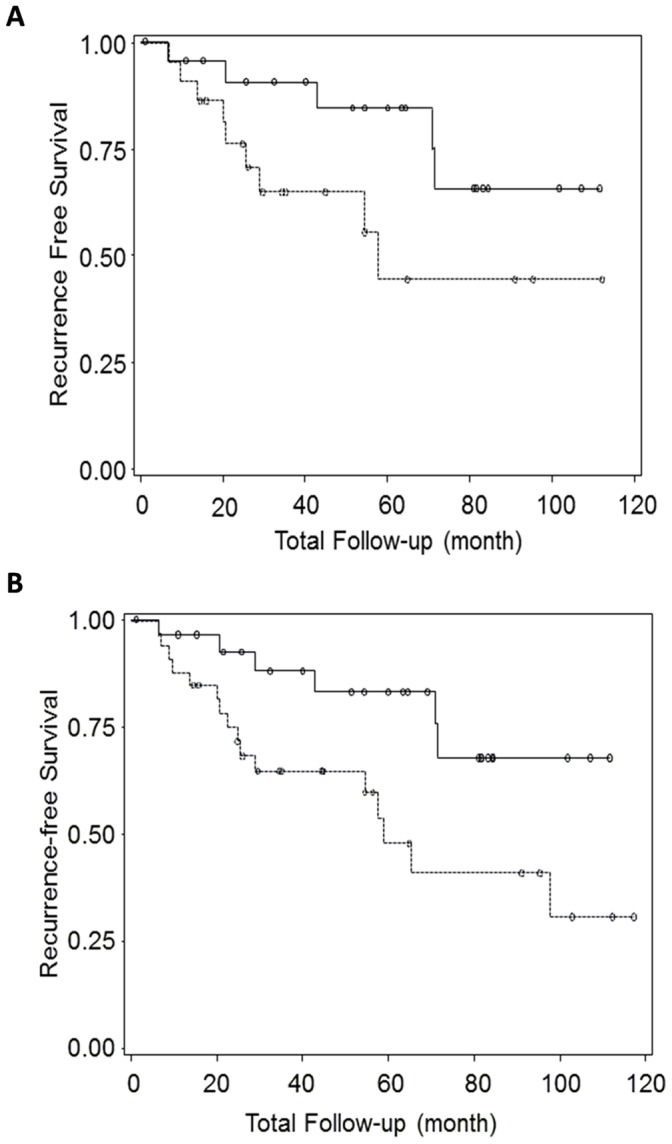
Kaplan-Meier survival curves for miR-9.Solid lines represent LR-free survival curves of breast cancer patients who had miR-9 low expression tumors in validation sample set, all cases (panel A) and ER positive cases (panel B). Dotted lines represent the patients who hadmiR-9 high expression tumors. P values are 0.08 and 0.02 for all cases (panel A) and ER positive cases (panel B), respectively.